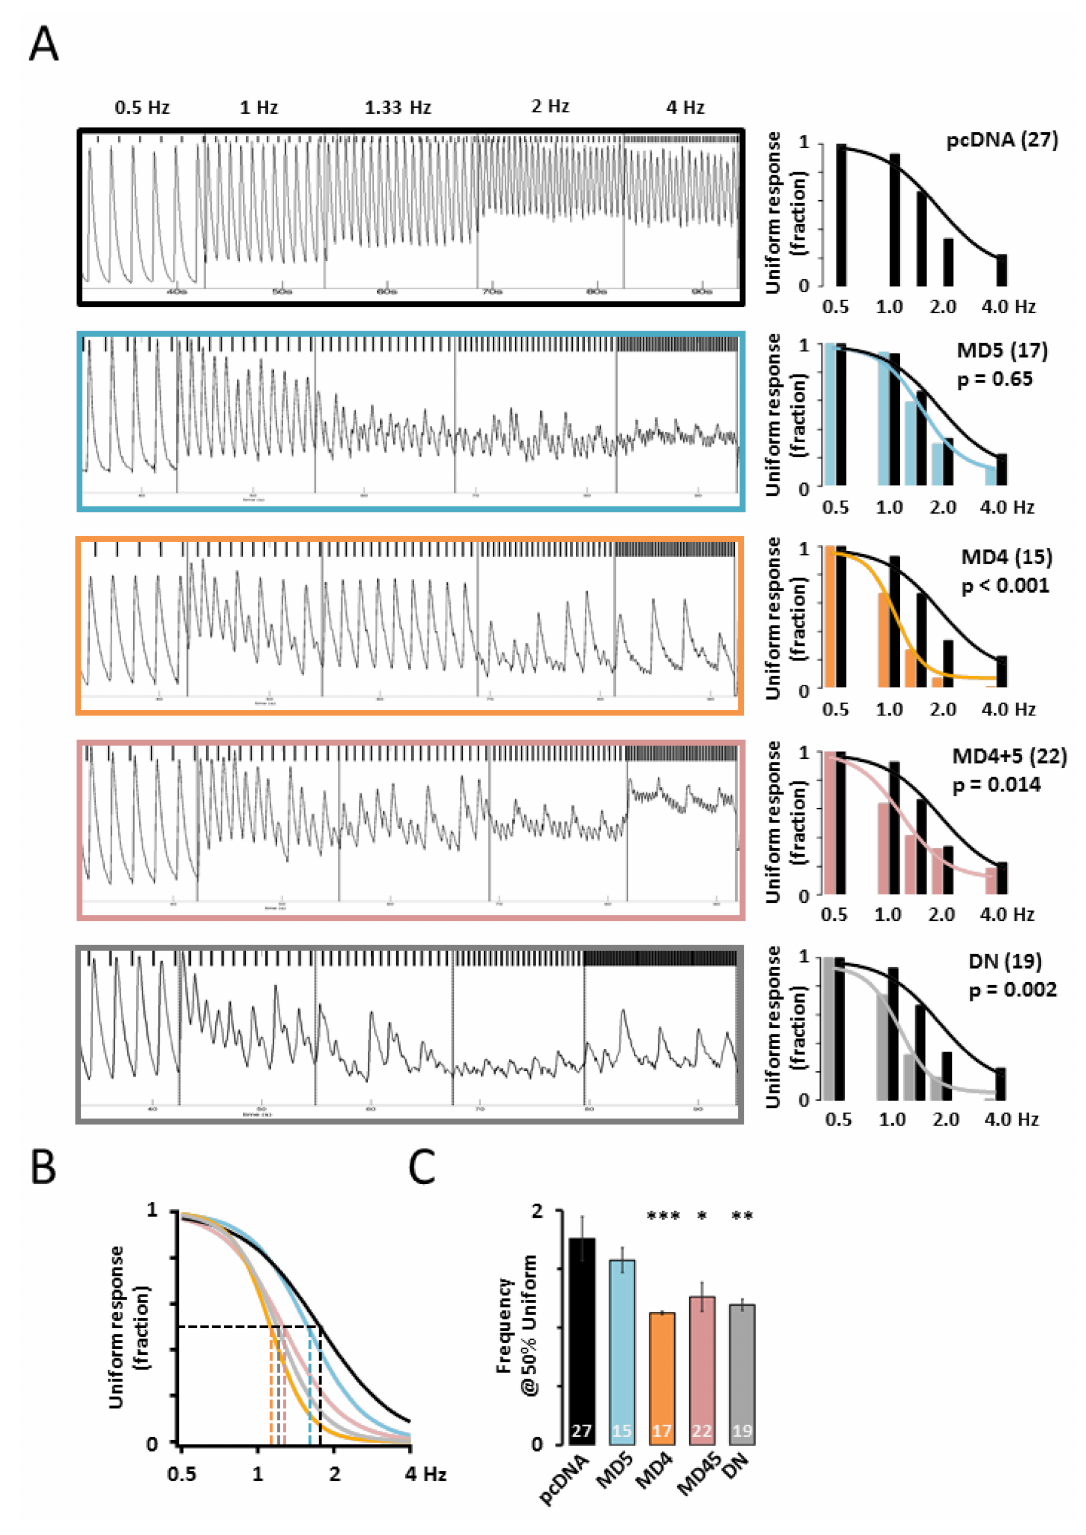
Figure 6. Impact of Pitx2 mutations on the beat-to-beat response. Panel ( A ). Traces of the beat-to-beat response recorded upon stepwise elevation of the stimulation frequency from 0.5 to 4 Hz are shown on the left for cultures transfected with pcDNA, DM5, DM4, DM4+5, or DN constructs. The corresponding fraction of uniform responses at the different stimulation frequencies is shown on the right and compared with pcDNA. Distributions of DM4, DM45 and DN were significantly different from the pcDNA distribution (ANOVA, p -values and n given for each construct). Data were fit with a Hill equation. Panel ( B ). Superimposed fits from panel ( C ) are shown on the left and the frequency where 50% responded uniformly is shown in ( C ). * p < 0.05, ** p < 0.01, *** p <